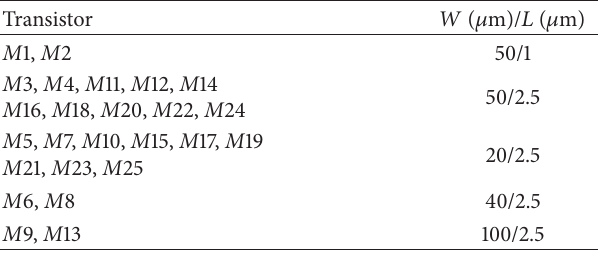
Table 1: Transistors aspect ratios of the circuit shown in Figure 2. Transistor 𝑊 ( 𝜇 m)/ 𝐿 ( 𝜇